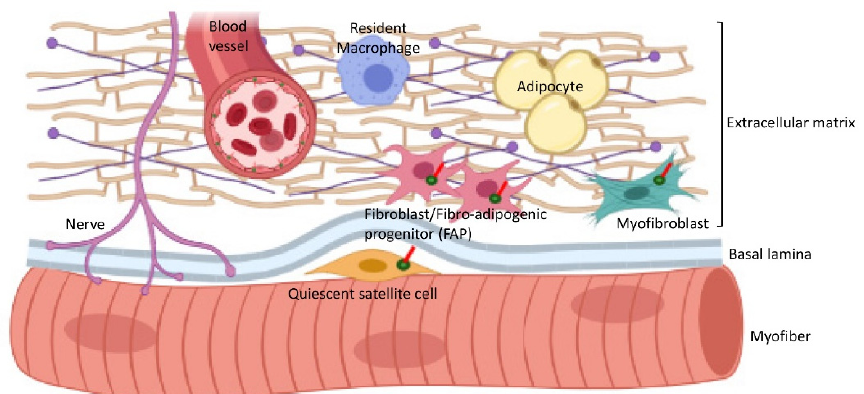
Figure 4. Diagram of skeletal muscle indicating cilia of a satellite cell on a myofiber surface and cilia of various cells in interstitial connective tissue. In the adult skeletal muscle, the quiescent satellite cell is on the myofiber and under the basal lamina. The myofiber is surrounded by the extracellular matrix, which also contains blood vessels, nerves, macrophages, fibroblast/fibro–adipogenic progenitor (FAP), adipocytes and myofibroblasts.